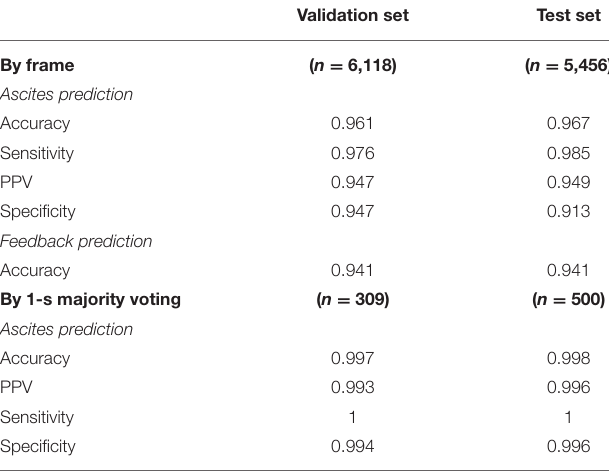
TABLE 2 | Model performance for ascites and image location feedback prediction. Validation set Test